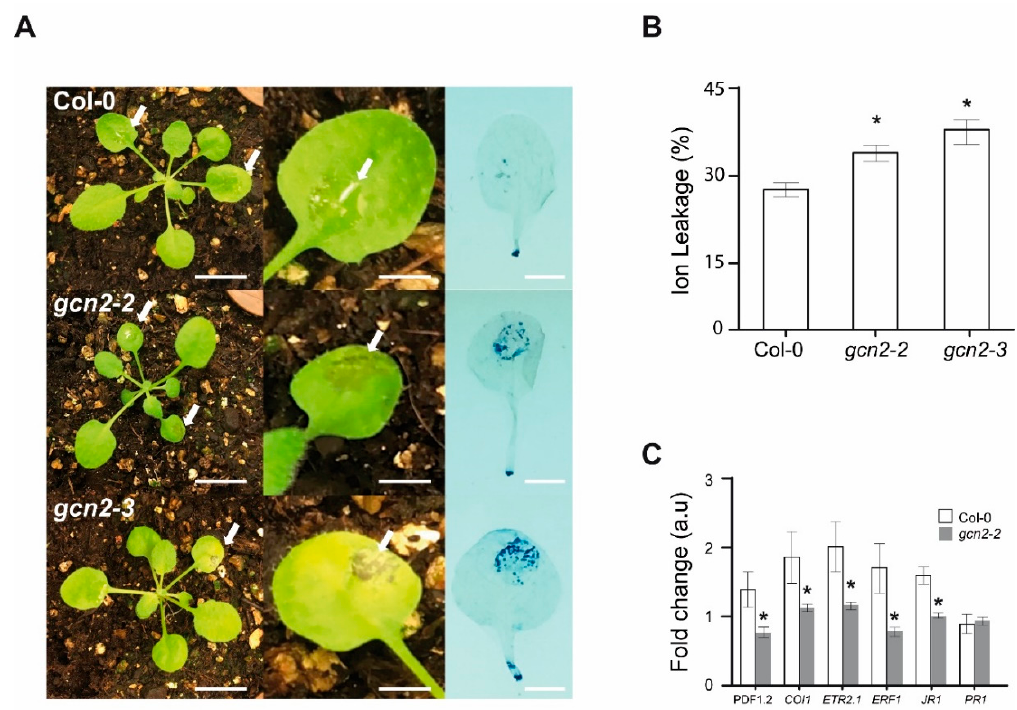
Figure 1. AtGCN2 participates in the defense response to Botrytis cinerea . ( A ) Representative disease symptoms in 3-week-old seedlings from Col-0 (WT) and gcn2-2 (SALKseq_032196) and gcn2-3 (SALKseq_129334) mutants at 3 dpi (right panel). For each experiment, two leaves from each plant were inoculated with 5 µ L of a Botrytis suspension (5 × 10 6 spores / mL). Close-up views of a representative B. cinerea infected leaf from each genotype (middle panel). In these two panels, lesions are highlighted with white arrows. Representative cell death symptoms on leaves detected by Trypan blue staining (right panel). Scale bars correspond to 1 cm in the left panel and 0.25 cm in the middle and right panels. These experiments were repeated independently at least three times, obtaining similar results. ( B ) Analysis of ion leakage from infected leaves of the same lines at 3 dpi. The percentage of ion leakage upon Botrytis inoculation is related to the total conductivity of the leaves after membrane and wall breakdown. n = 6 independent experiments including 10 leaves per genotype. Statistical di ff erences (* p ≤ 0.05) are highlighted by asterisks. ( C ) qRT-PCR analysis of AtPDF1.2 , AtCOI1 , AtETR2.1 , AtERF1 , AtJR1, and AtPR1 transcription levels at 1 dpi. Fold change expression is related to the expression of each gene in the corresponding genotype under control conditions (i.e., in the absence of fungus), which was arbitrarily assigned value 1 after normalization to β -ACTIN (internal normalization control). In this case, three biological replicates were analyzed. For (B and C), values are shown as mean ± SEM. In both cases, statistically significant di ff erences (* p < 0.01) were calculated using one-way ANOVA test.